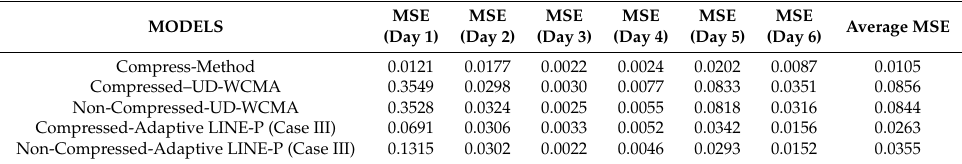
Table 17. Error estimation MSE of the prediction models with and without the compressed profile for the solar energy